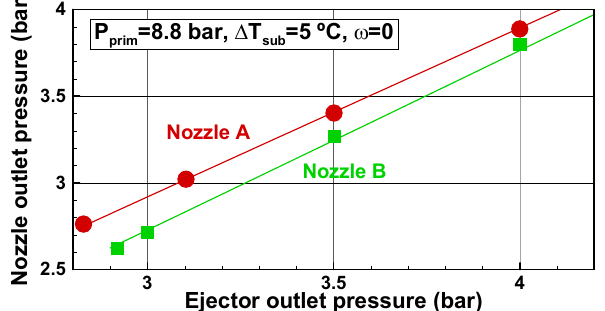
Figure 6. Pressure at the nozzle outlet.